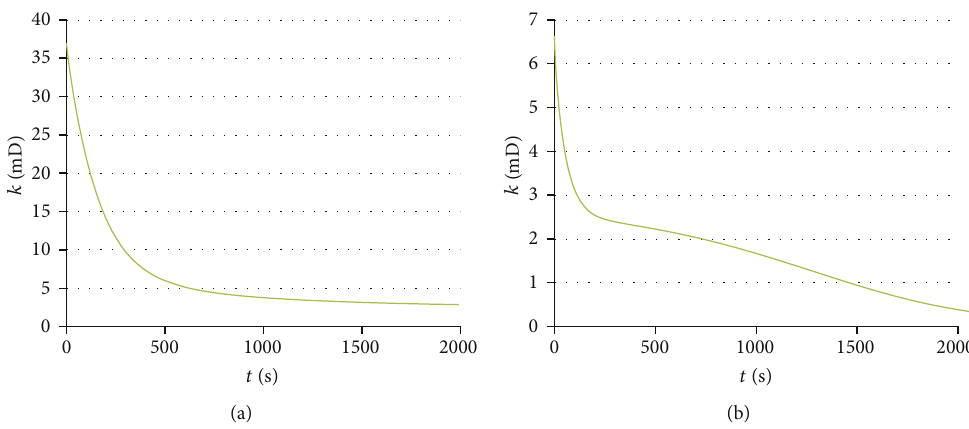
Figure 15: Variation curves of overall permeability of coal samples with time. (a) Coal sample 1#. (b) Coal sample